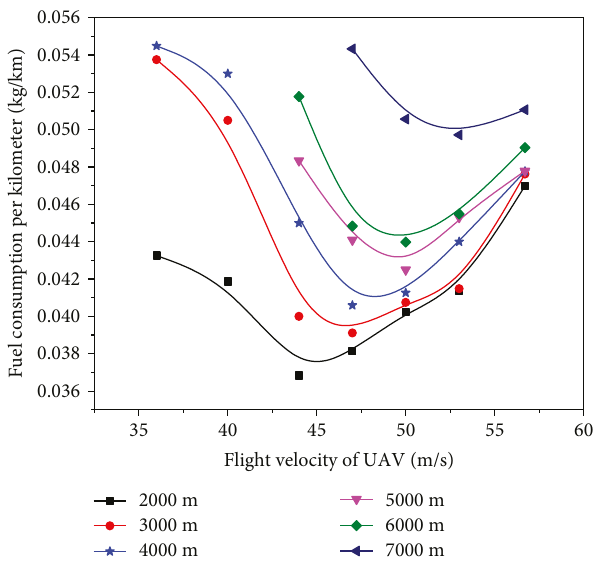
Figure 20: Fuel consumption per kilometer of UAV at di ff erent altitudes.